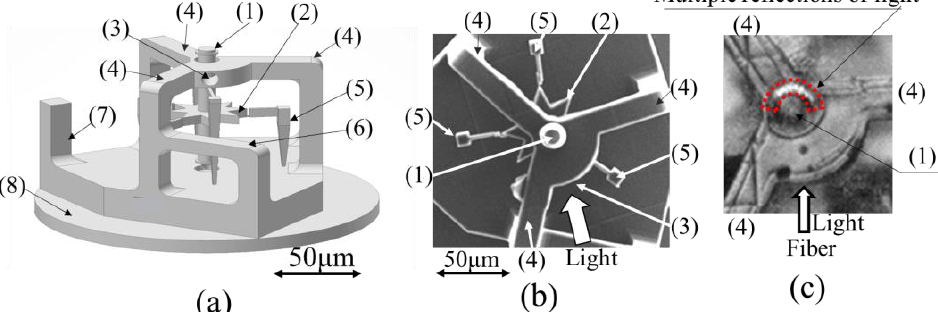
Figure 7. Rotor shaft friction-reduction model: (1) Shaft, (2) Rotor, (3) Entrance of light, (4) Beam, (5) Support, (6) Fiber stand, (7) Fiber partition, (8) Base, ( a ) Three-dimensional CAD model, ( b ) SEM image of experimental apparatus (top view), ( c ) Confirmation of multiple reflections of light on the shaft gap.